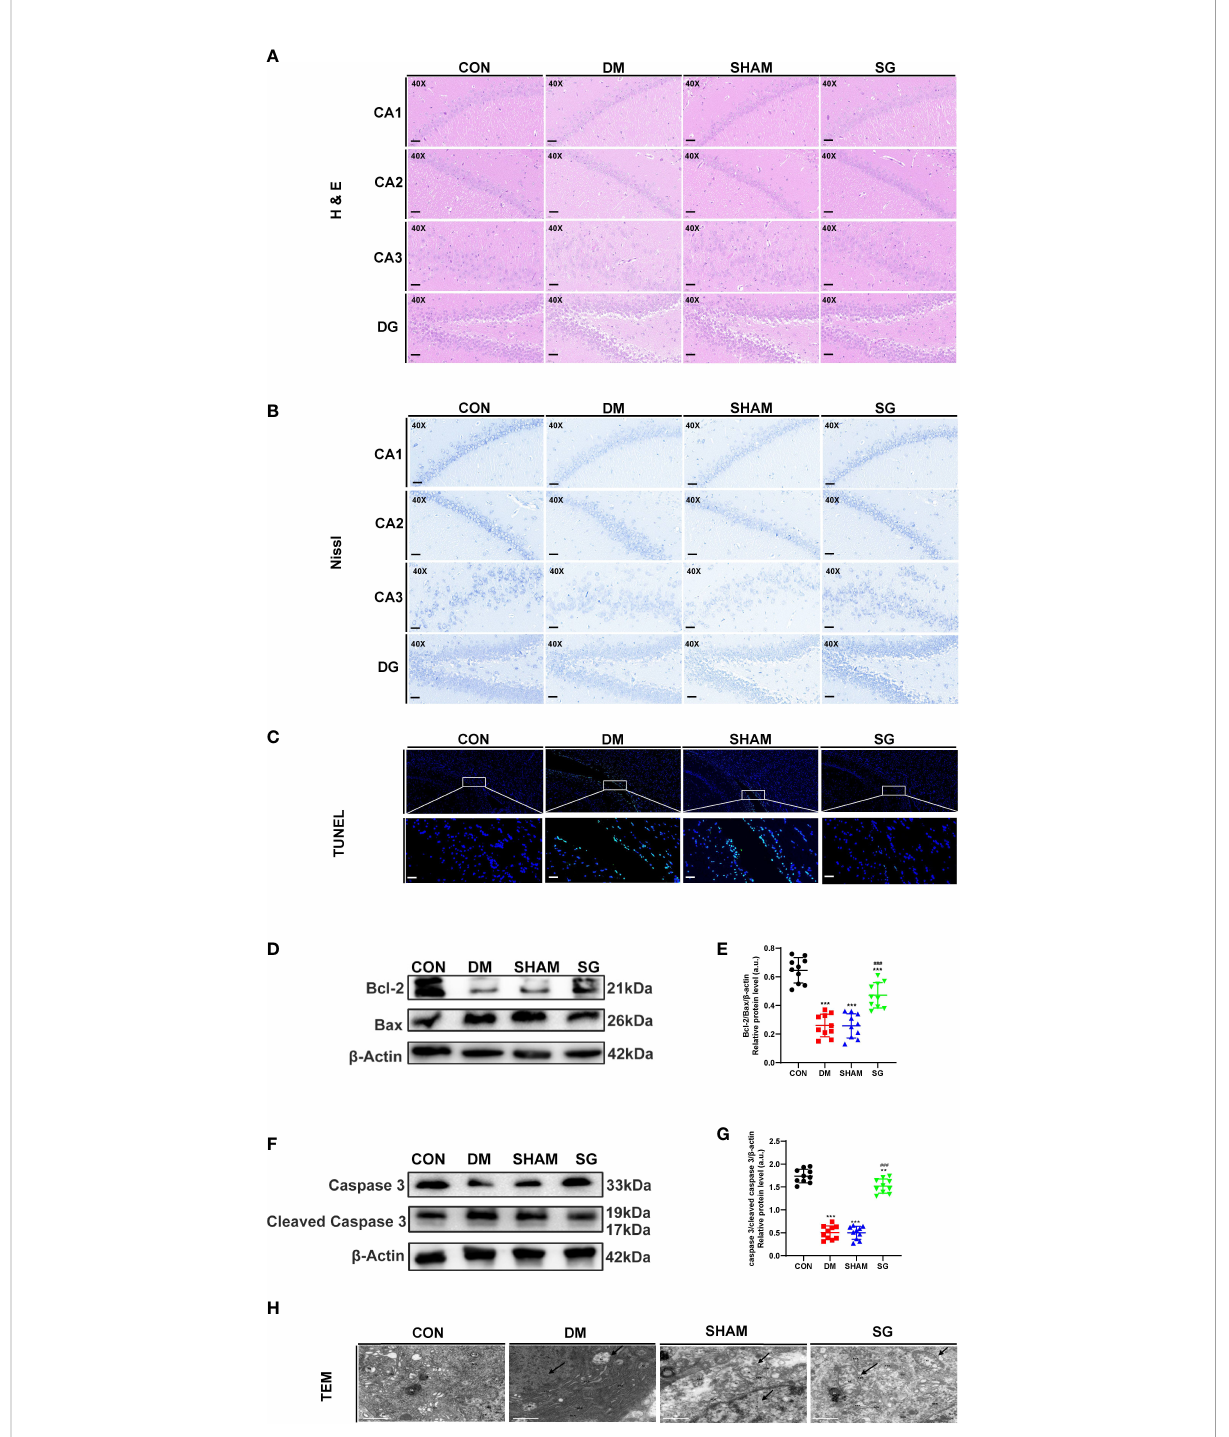
FIGURE 4 SG reversed the histological features (A) , induce the increase of Nissl ’ s bodies (B) , and inhibited the apoptosis of hippocampus neurons (C-G) , and improved the microstructure of hippocampus neurons under TEM (H) . The scale bar for A-C was 100 µm, while that for H was 1 µm. Data were expressed as means ± SEM for n = 10 per group. ** p < 0.01 vs. CON group, *** p < 0.001 vs. CON group; ### p < 0.001 vs. SHAM group. H&E, hematoxylin and eosin; TUNEL, terminal deoxynucleotidyl transferase-mediated dUTP nick end labeling; CA1, cornu ammonis1;